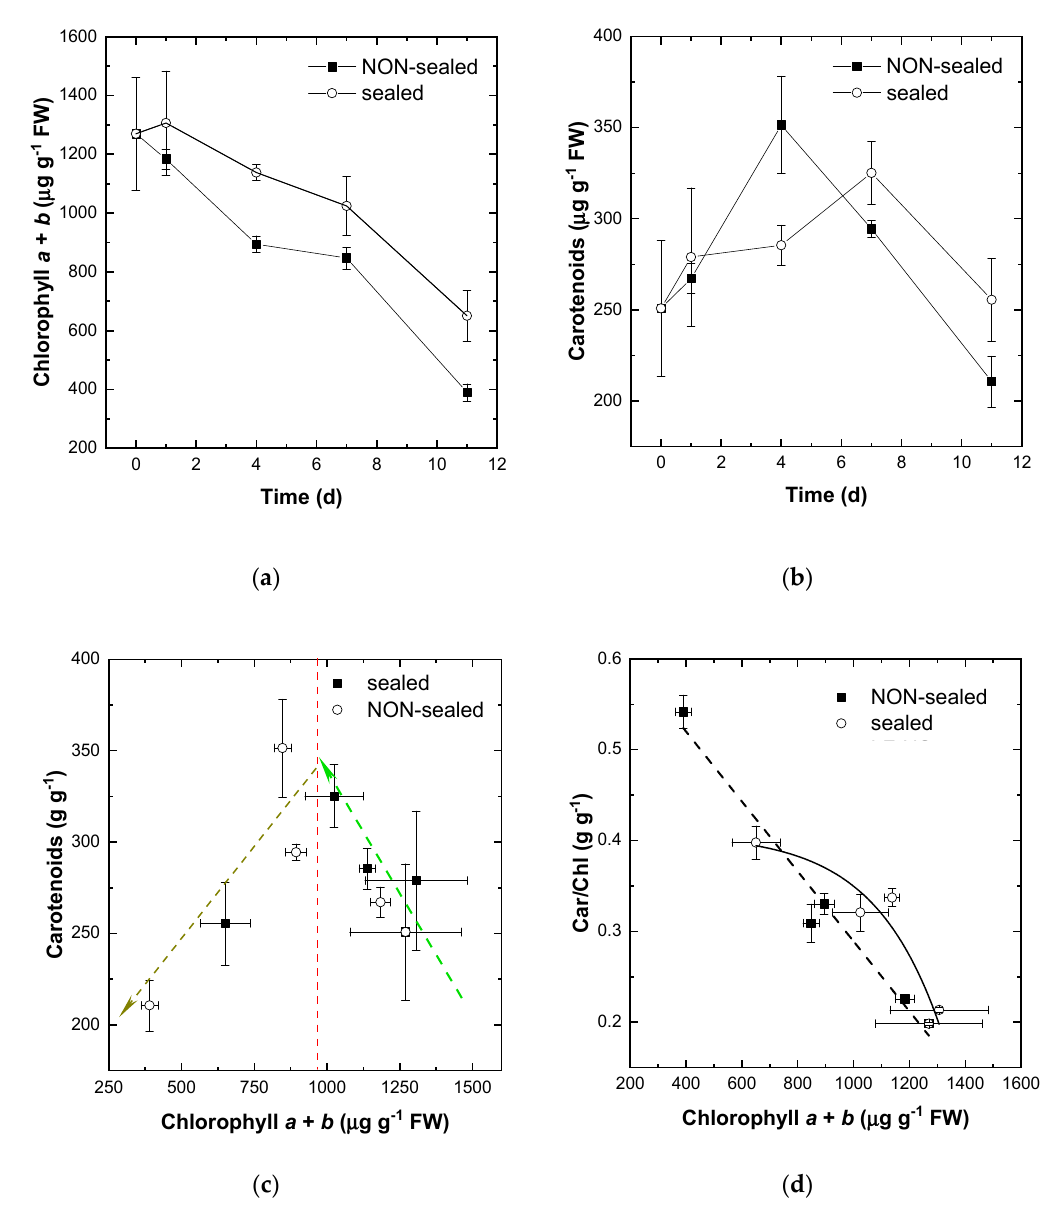
Figure 4. Changes in pigment composition during storage of the non-sealed (closed symbols) and sealed (open symbols) fresh-cut lettuce leaves. ( a ) Time-course of [Chl]. ( b ) Time-course of [Car] changes. ( c ) Relationship between total and [Chl] changes. ( d ) Changes of [Car]/[Chl] mass ratio plotted vs. changes in [Chl]. Average ± SE values are presented ( n =